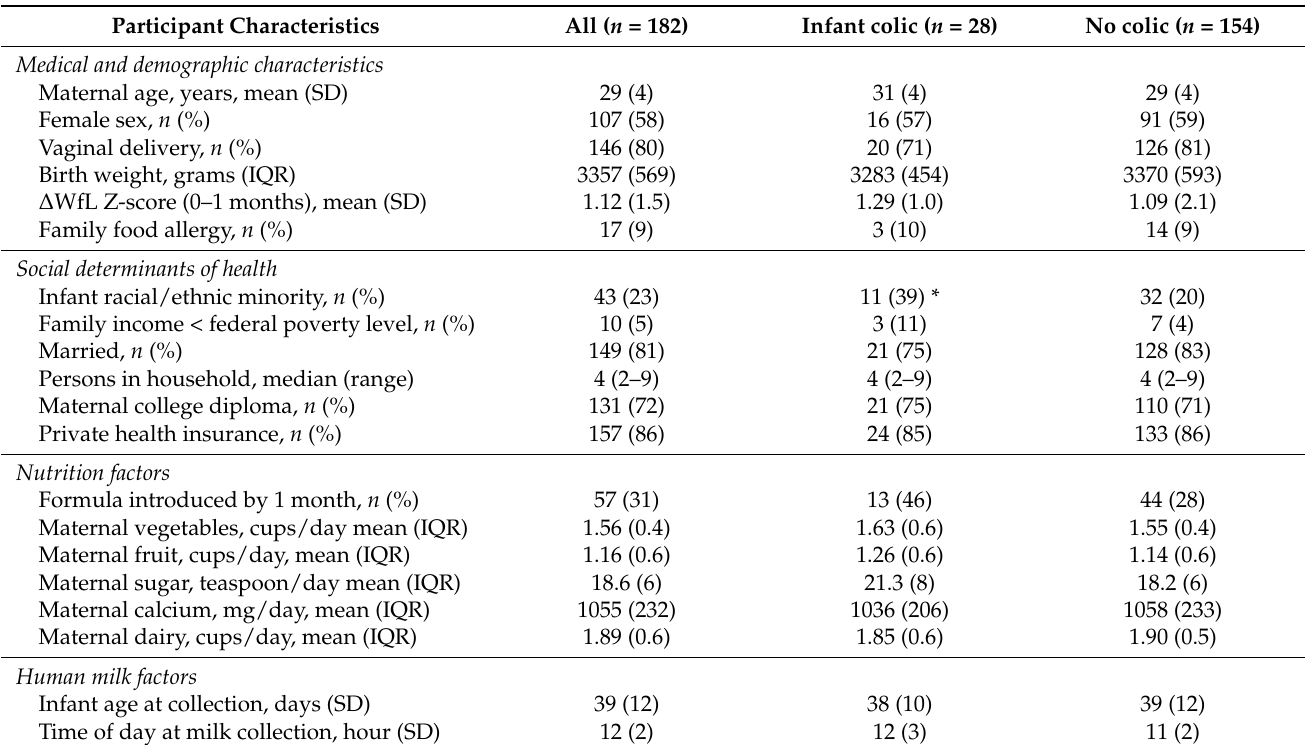
Table 1. Participant characteristics. Medical/demographic factors, social determinants of health, and nutrition factors are displayed for infants with colic and peers without